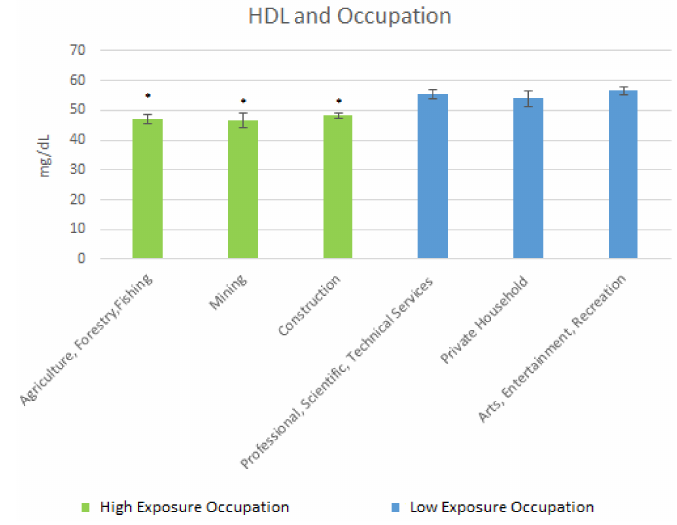
Figure 7. Occupation and Mean HDL Levels. * Significant difference between low exposure occupations and high exposure